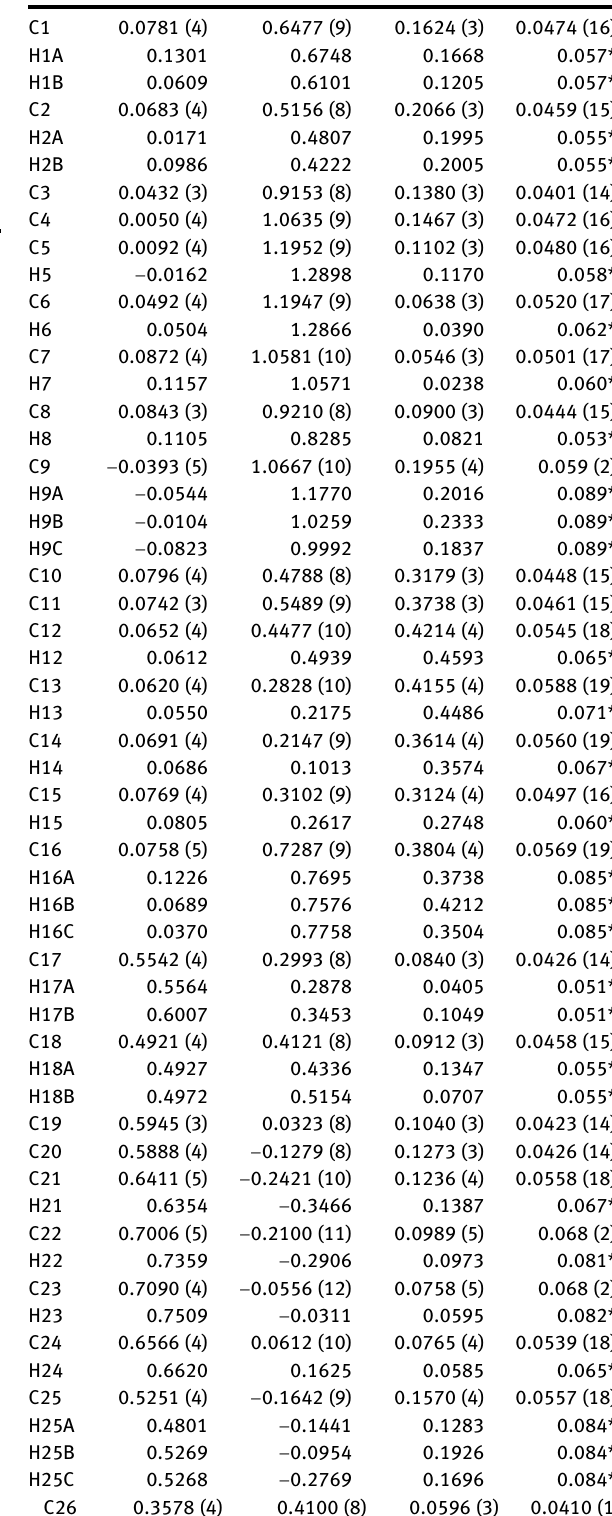
Table  : Data collection and handling. Crystal: Yellow sphere